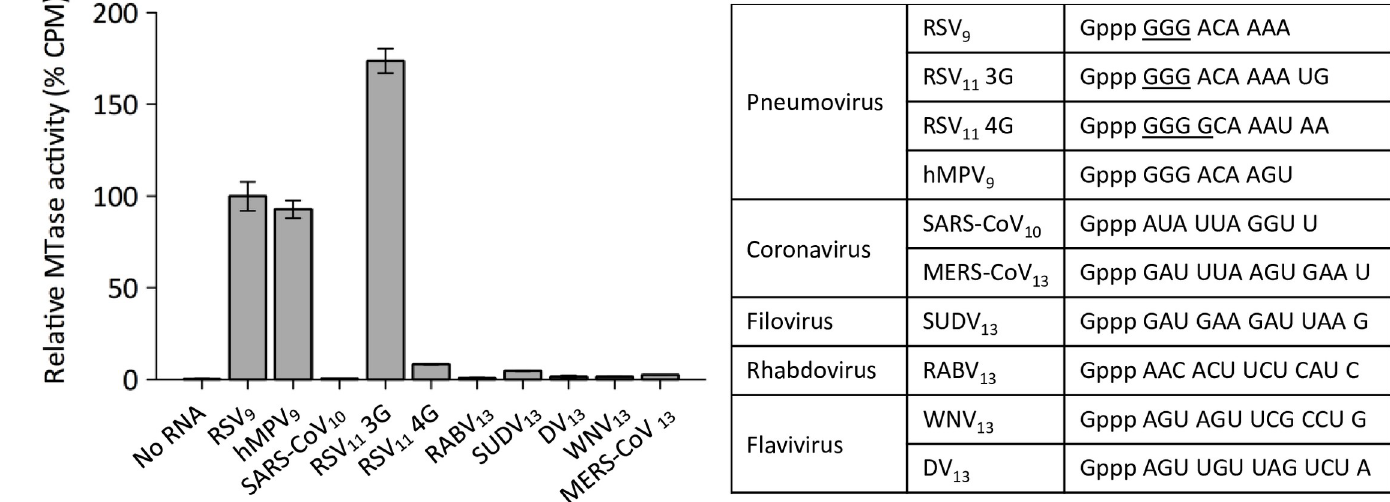
Fig 4. RSV MTase activity is sequence-specific. Substrate specificity was determined by filter-binding assay, using the synthetic capped RNA substrates with different 5’ end sequences and lengths (numbers after virus abbreviation) described in the table on the right. hMPV, human Metapneumovirus; SARS-CoV, Severe Acute Respiratory Syndrome Coronavirus; MERS, Middle East Respiratory Syndrome; SUDV, Sudan Ebolavirus; RABV, Rabies virus; WNV, West Nile virus; DV, Dengue virus. The RSV MTase-CTD was used at 25 nM. Values were normalized to the activity on Gppp GGG RSV 9 , and are the mean ± SEM ( n =